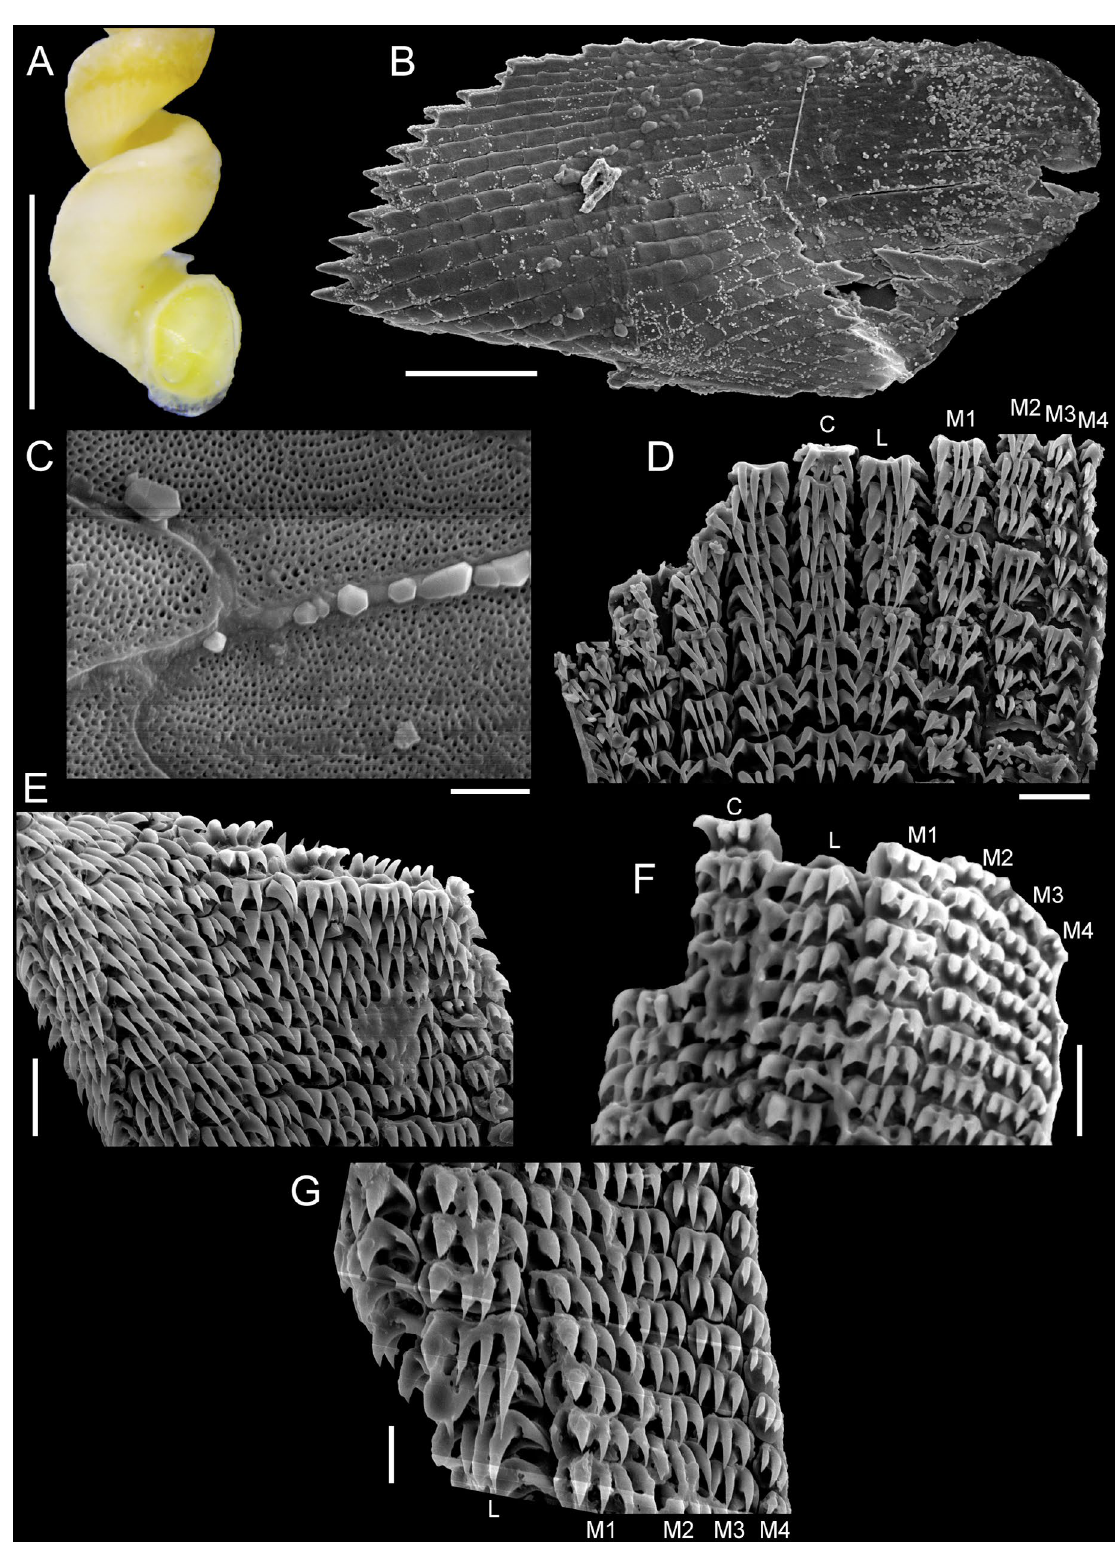
Fig. 3. Metaxia excelsa Faber & Moolenbeek, 1991. A–G . MZSP 122353. A . External morphology. B–C . Jaw, outer side. D–G . Radula. Scale bars: A = 1 mm; B = 50 µm; C = 2 µm; D–F = 10 µm; G = 5